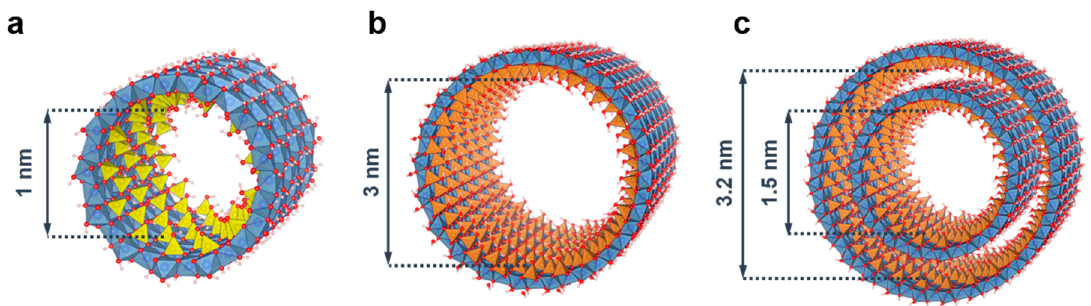
Figure 3. Inner diameter size for the different endmembers of (OH) 3 Al 2 O 3 Si x Ge 1 − x (OH) imogolite nanotubes. ( a ) Si-SWINT; ( b ) Ge-SWINT; ( c ) Ge-DWINT. Color code: aluminum (blue); silicon (yellow); germanium (orange); oxygen (red); hydrogen (white).